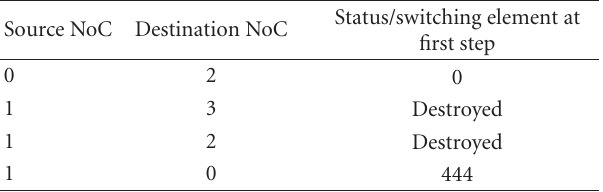
Algorithm 3: NoC WS IRREGULAR PNN. Table 8: Intermediate SE information while data moves from source NoC to destination NoC at first step of worst case.